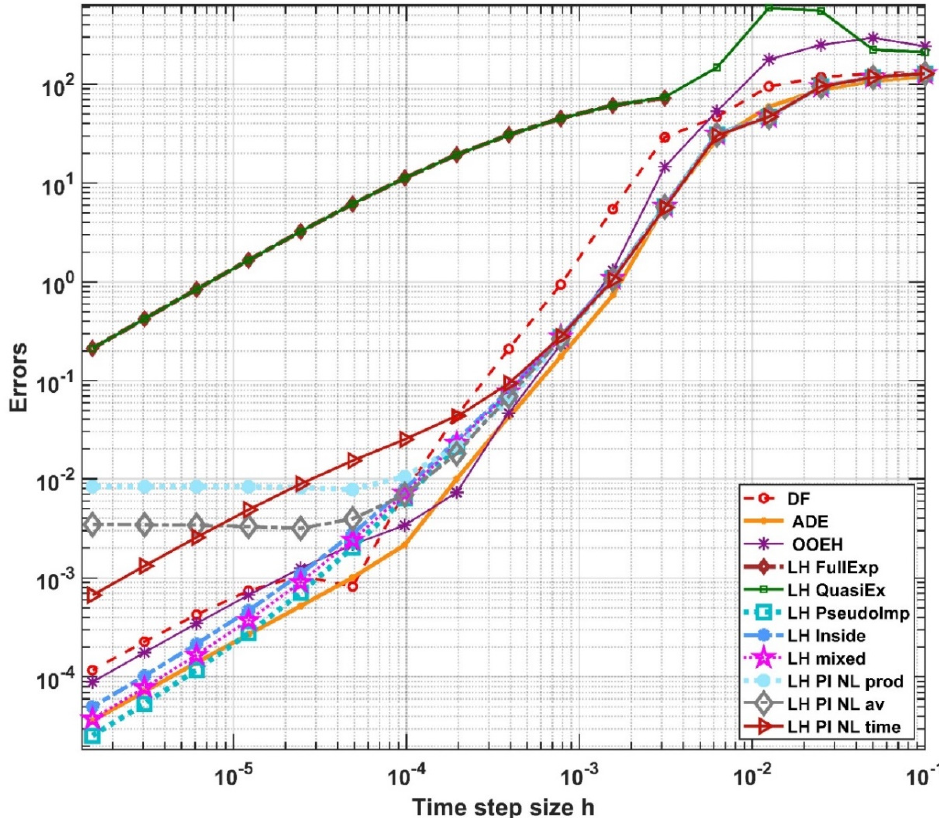
Figure 7. The L ∞ errors as a function of the time step size h (Experiment 4).